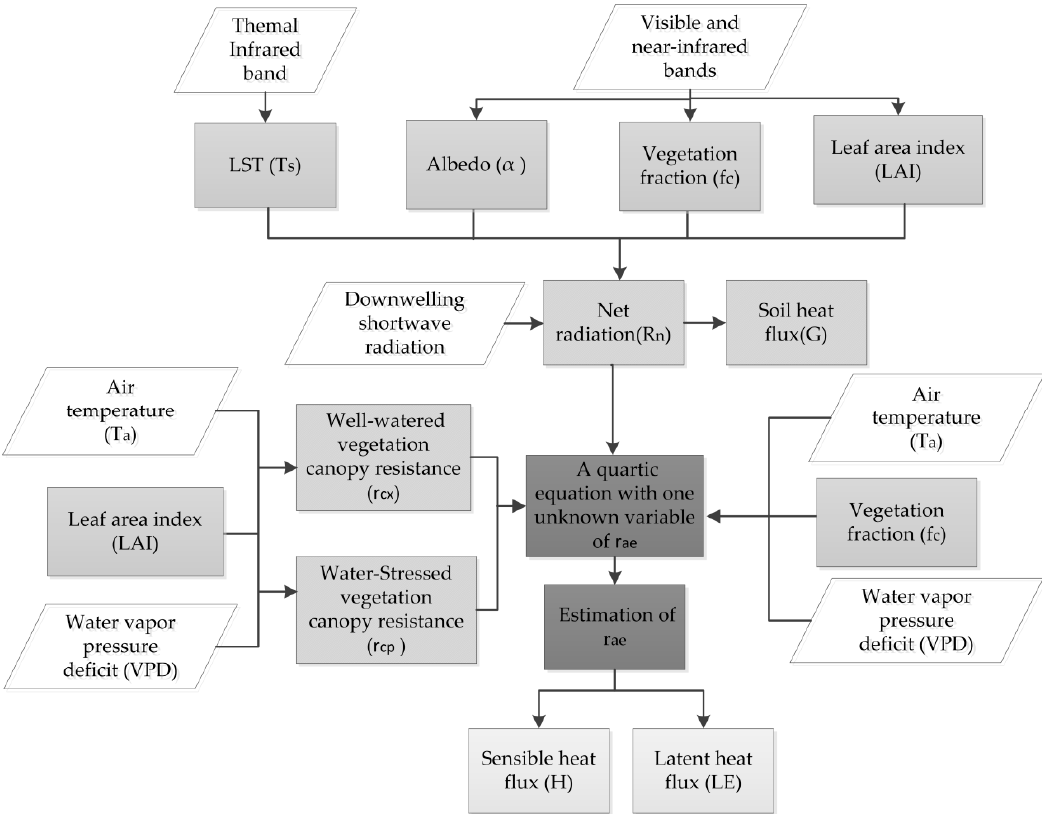
Figure 2. Flow chart of One-Source Model for Land (OSML) implementation, where diamond-shaped boxes represent OSML input from meteorological observations and remote sensing retrievals, while light-gray rectangles represent intermediate variables or parameters, and the dark-gray rectangles represent the main procedures for solving r ae and consequently estimating surface heat fluxes.